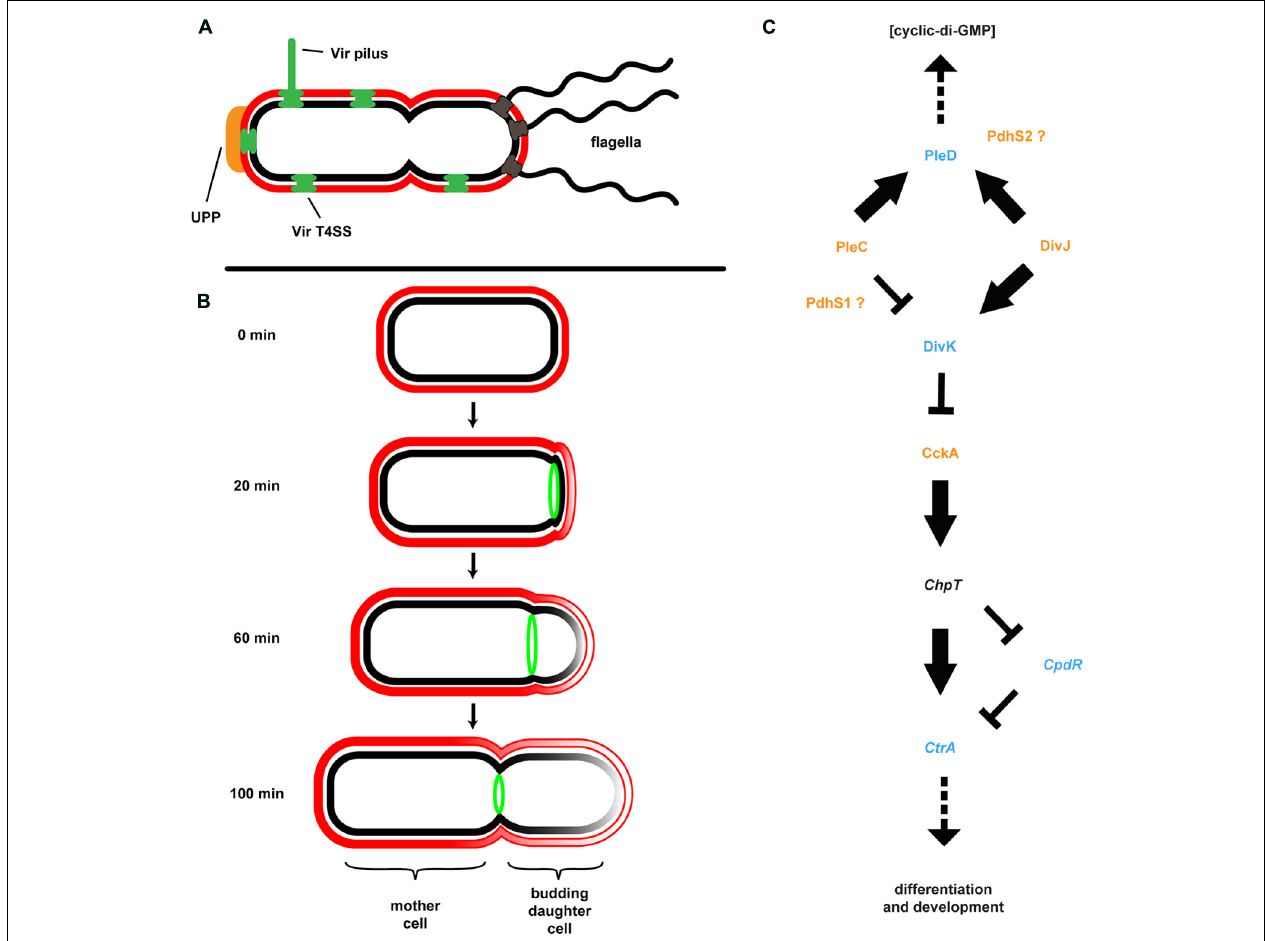
development (CDD) regulatory pathway. Proteins for which genetic and/or phenotypic data confirm the suggested pathway architecture are in bold typeface. Italicized proteins are present in the A. tumefaciens genome but do not have experimental support; placement of these proteins in the pathway is based on data from other model systems. Histidine kinases are colored orange, response regulators are colored blue, and a single Hpt phosphotransferase (ChpT) is in black text.The location of PdhS1 and PdhS2 is suggested by current data, but not confirmed. Note that the bacterial cell envelope in all panels is depicted as described in Figure 3